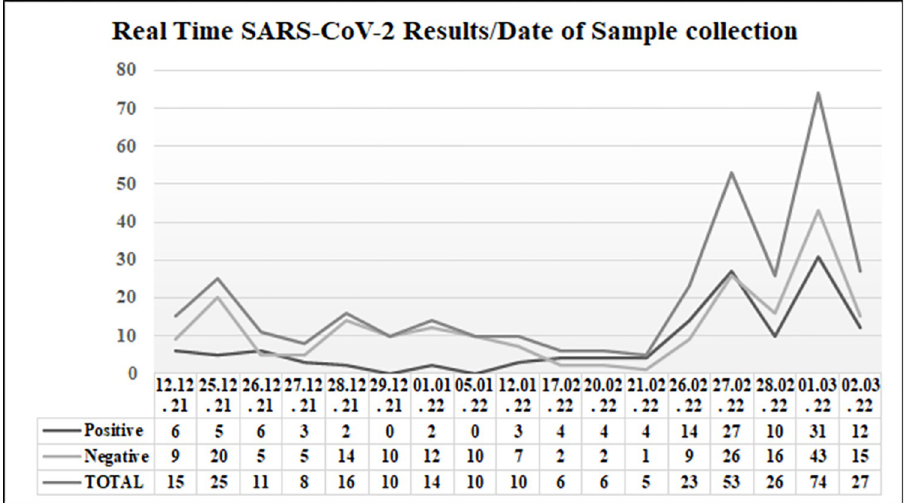
Fig 1. Temporal distribution for SARS-COV-2 testing results over the study